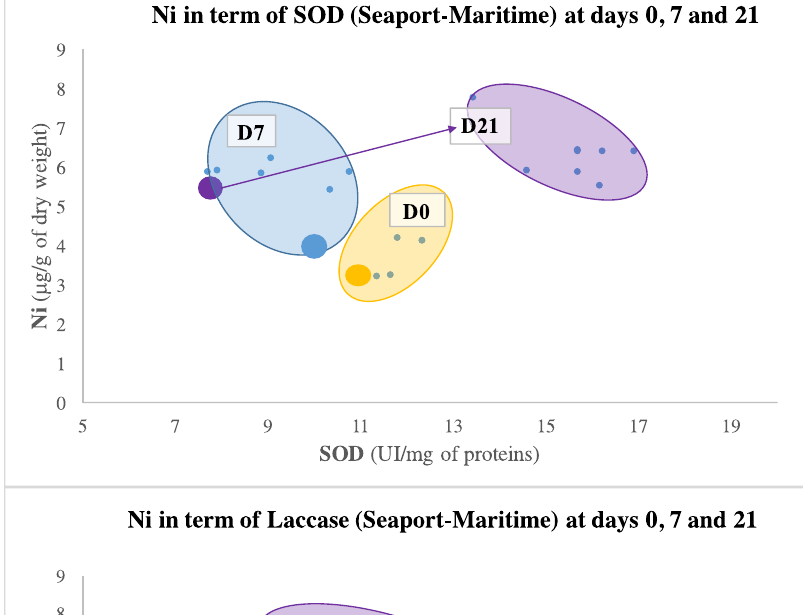
Fig 9. Specific pollution of Ni depending on SOD (struggle against ROS), Laccase (immunomodulation) and MDA (destruction of cell membranes) at the seaport (Maritime).